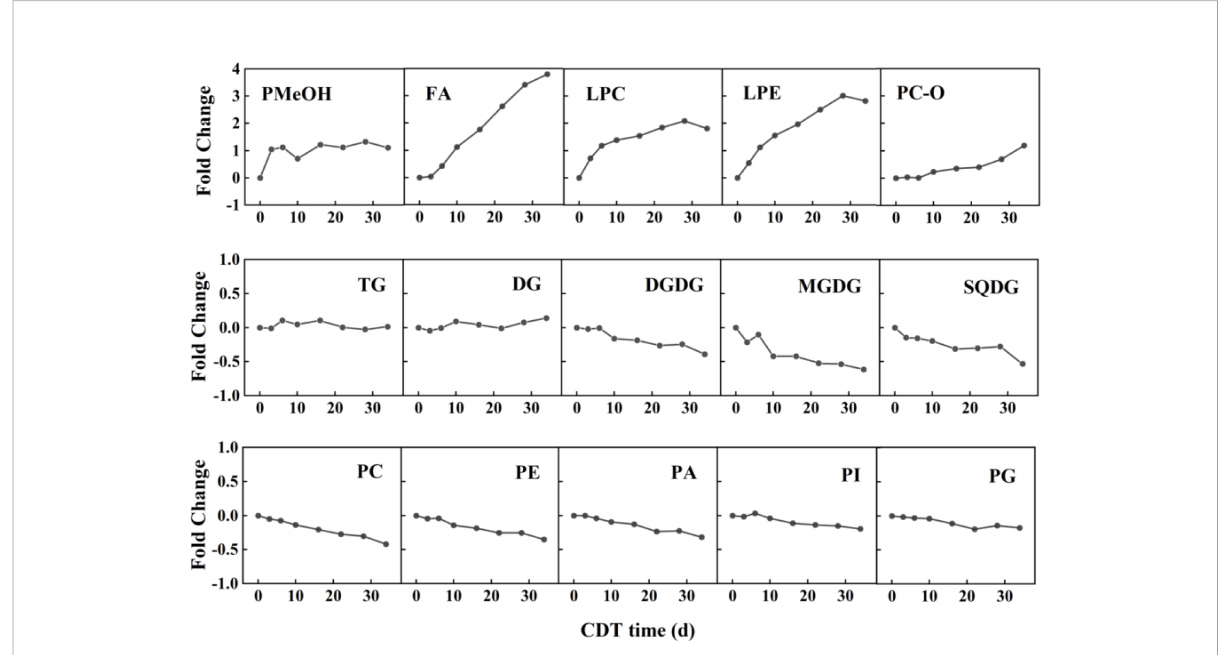
FIGURE 3 Fold changes in lipids of aged saf fl ower seeds. The fold change was calculated as the mean (n = 3) of each class of total lipids using the formula (A2-A1)/A1, where A2 is the total amount of lipid class represented at the speci fi ed aging time point, and A1 is the total amount of the speci fi ed lipid class on day 0 (C0). CDT, controlled deterioration